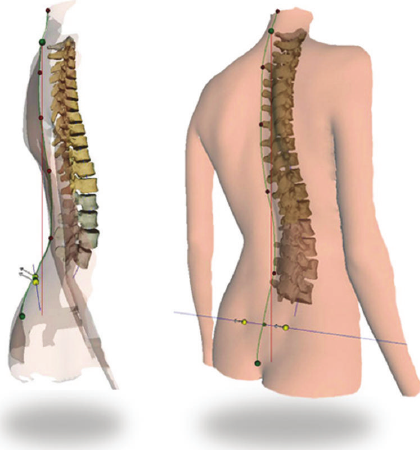
Figure 5: Three-dimensional computerized representation of the subject’s underlying spine based on surface